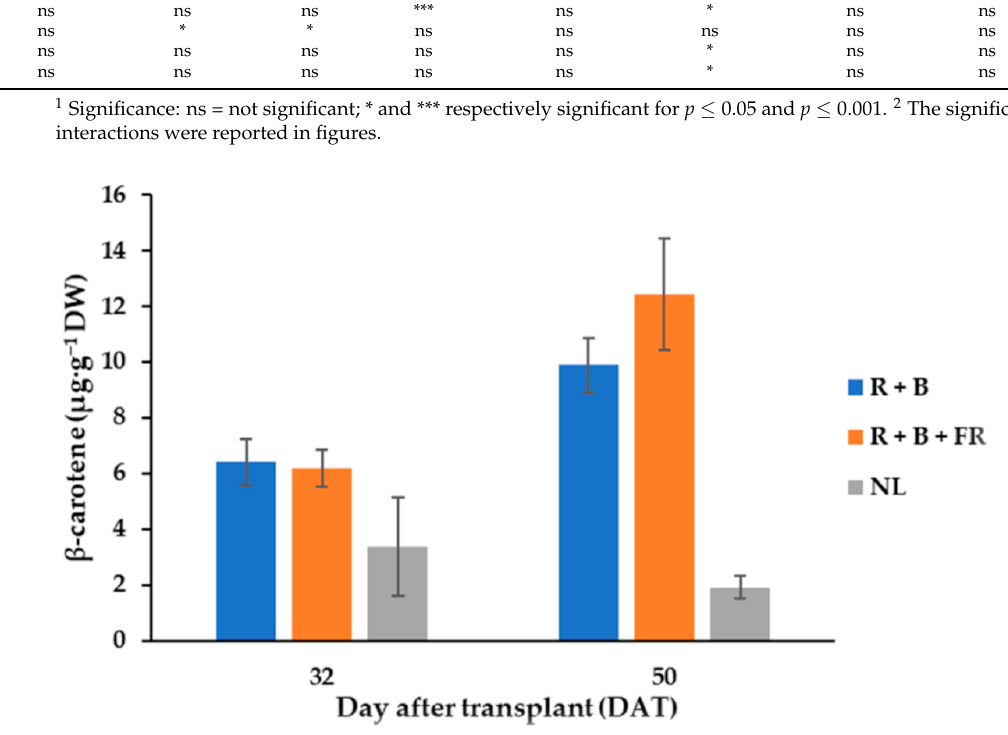
Figure 4. β -carotene content of “Carosello leccese” ( Cucumis melo L.) fruits from plants grown under solar light (NL, no supplementary lighting) and two light spectra (see Figure 1). Values are an average of three replications. Bars represent mean values ± standard error. R + B represents supplementary light with red + blue spectra; R + B + FR represents supplementary light with red + blue + far red spectra; NL represents solar light (control) treatment. Fructose was the most abundant among sugars identified and it was 12% higher for the fruits harvested 32 DAT than those harvested 50 DAT (Table 4). Dissimilarly, glucose did not vary in these samples, but it was 8% higher in the fruits obtained under